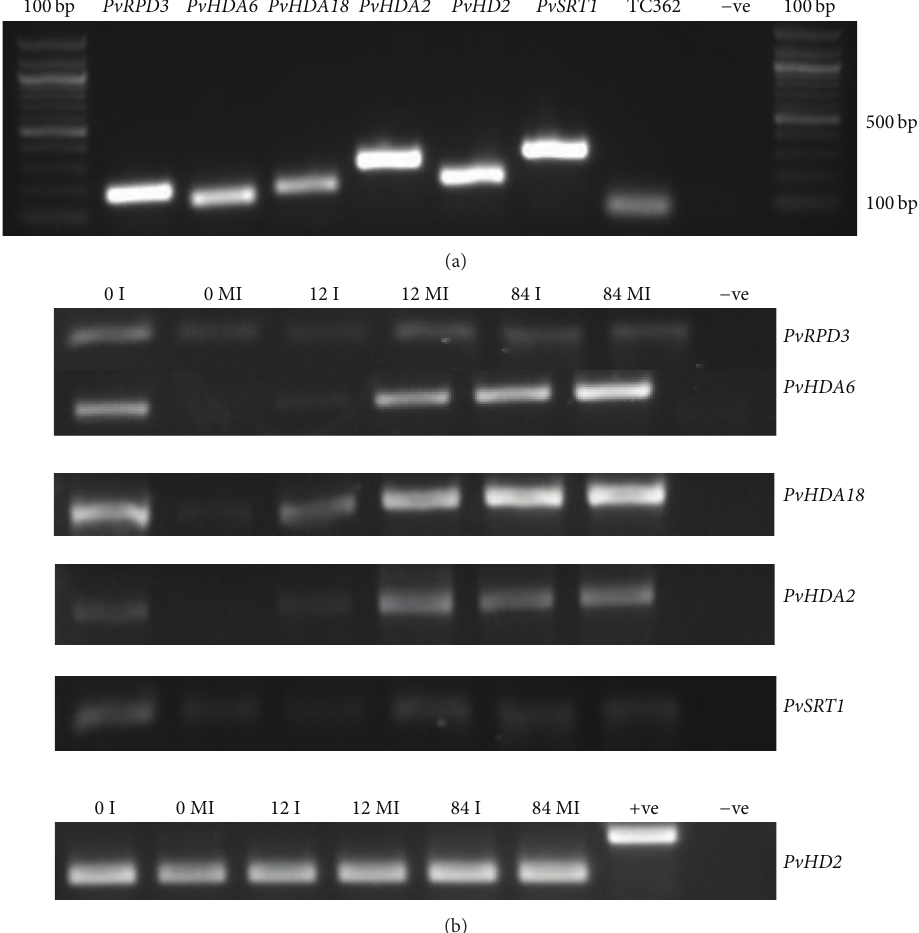
Figure 4: PCR amplification of HDAC genes under study. (a) Primers for the selected genes were amplified by PCR with Sierra genomic DNA and electrophoresed on a 2% agarose gel. In positive (+ve) control, reference gene TC362 primers were used and in negative ( − ve) control no primers were added to the PCR reaction. (b) The same HDACs primers were tested with experimental cDNA by PCR amplification and electrophoresed on a 2% agarose gel. In +ve control, genomic DNA was used instead of cDNA and in − ve control no primers were added to the PCR